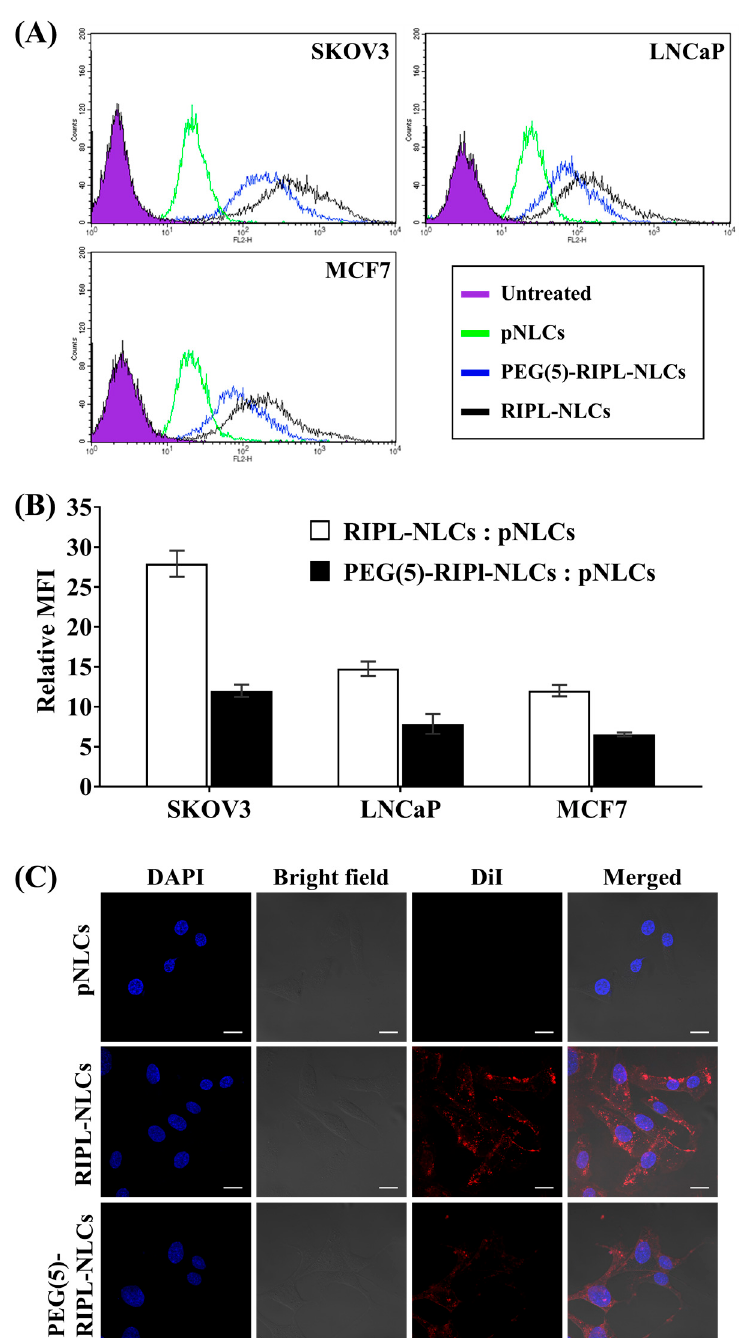
Figure 5. Cellular uptake of DiI-loaded NLCs by the SKOV3, MCF7, and LNCaP cell lines. ( A ) Flow cytometry histogram of plain NLCs (pNLCs), RIPL-NLCs, and PEG(5)-RIPL-NLCs uptake. ( B ) The relative MFI values of treatments: RIPL-NLCs versus pNLCs and PEG(5)-RIPL-NLCs versus pNLCs. Data are the mean ± SD ( n = 3). ( C ) CLSM images of SKOV3 cells incubated with DiI-loaded NLCs. Scale bar = 20 µm.